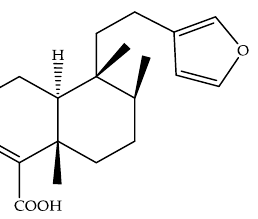
Figure 1. Chemical structure of ent -hardwickiic acid.